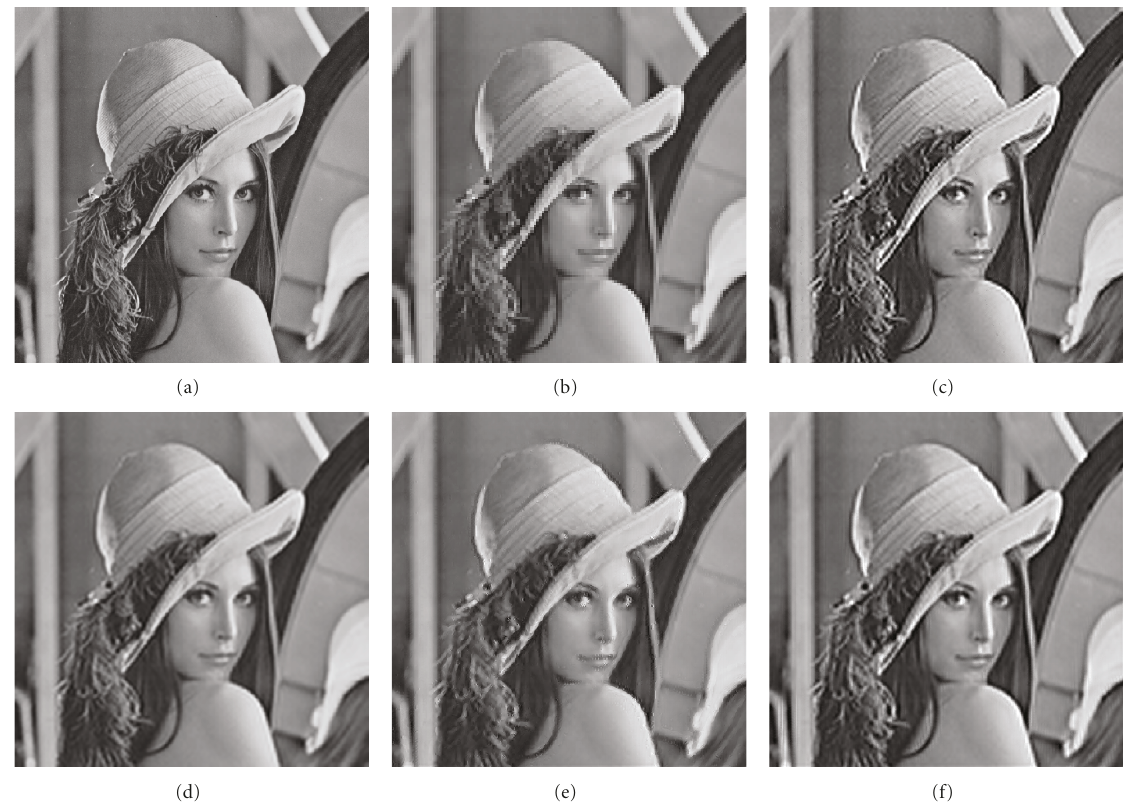
Figure 3: Subjective performance comparison between the proposed method and the conventional methods (The magnification factor was set to four): (a) original HR image “Lena” (512 × 512 pixels), (b) LR image (128 × 128 pixels), (c) HR image estimated by the proposed method, (d) HR image estimated by the interpolation using Lanczos filter, (e) HR image estimated by [10], (f) HR image estimated by [21].